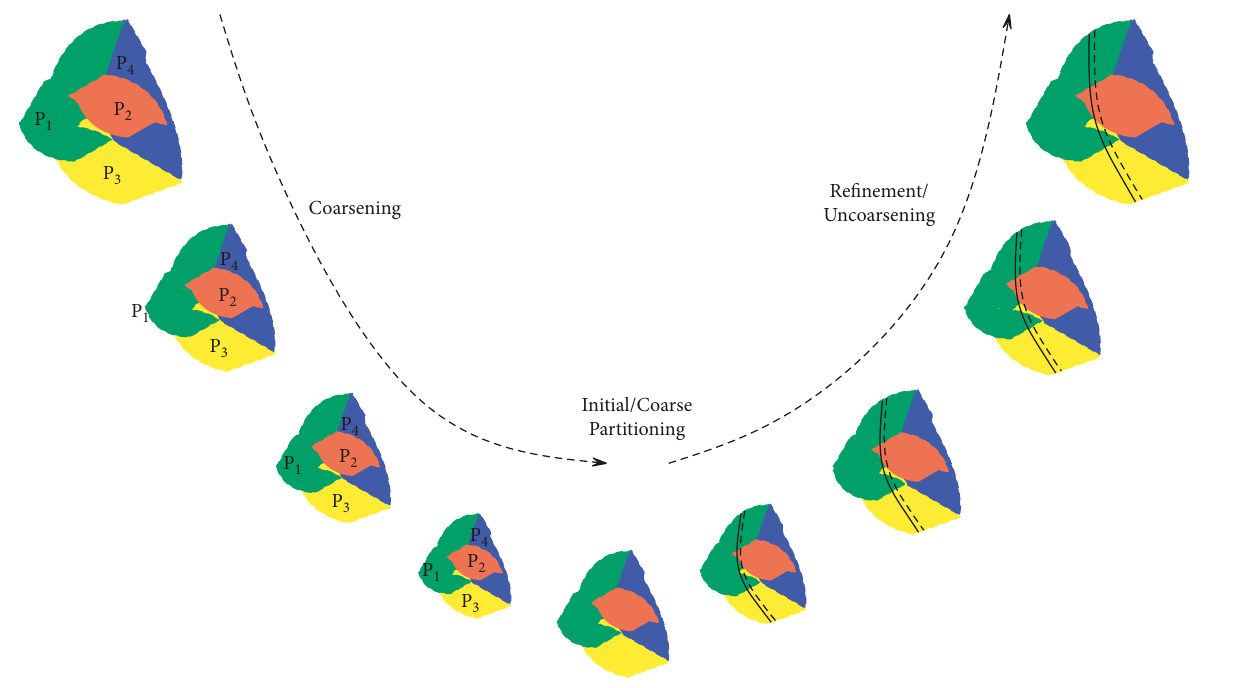
Figure 7: Demonstration of the hypergraph repartitioning